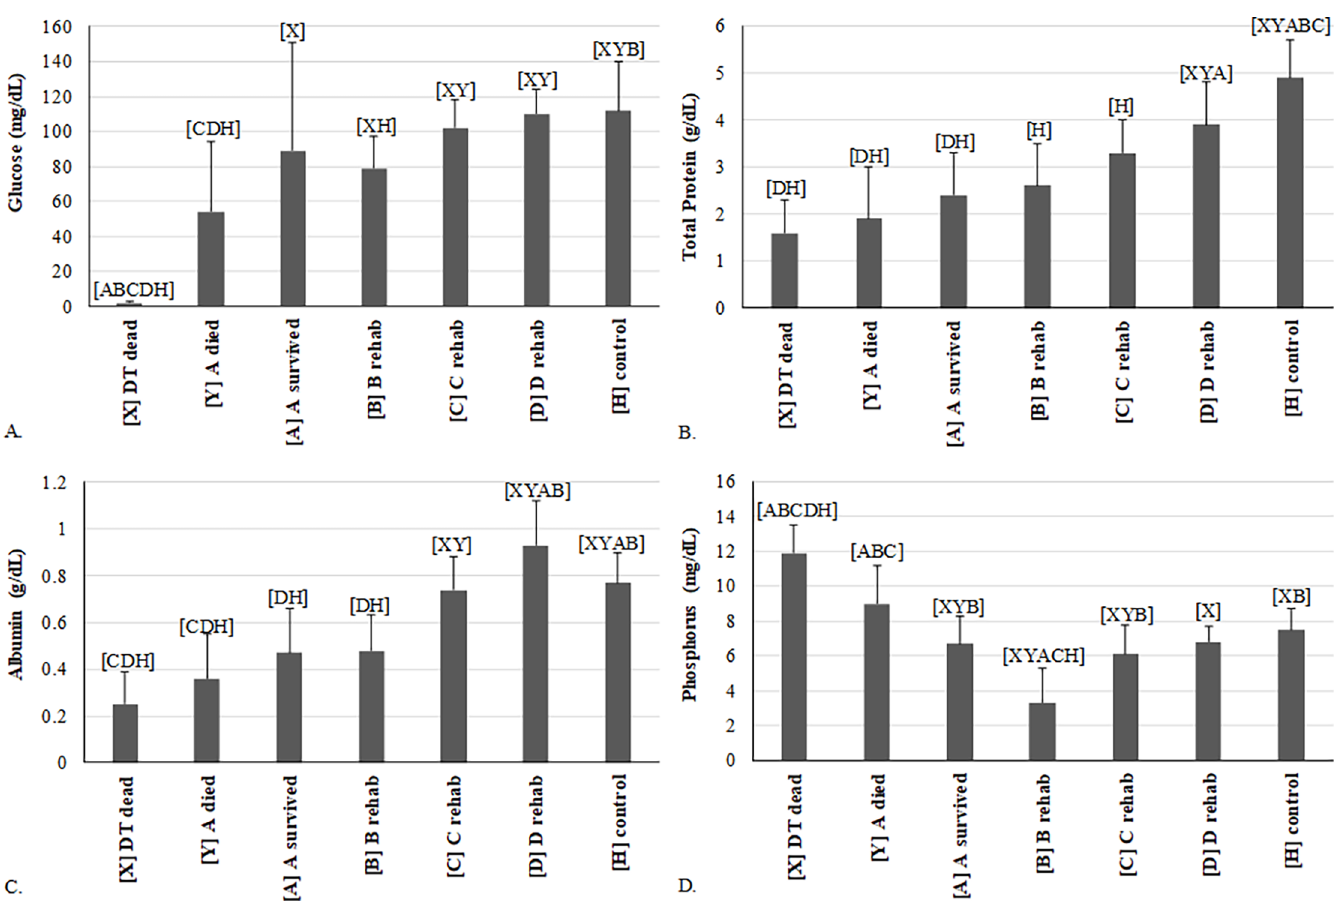
Fig 4. Comparison of variables measured in debilitated loggerhead sea turtles (DTs) before and during rehabilitation and compared to healthy loggerhead turtles (means and one standard deviation). Each turtle group on the x-axis was significantly different (p < 0.05 or p < 0.00883 for repeated measures) from groups represented by letters above data. (A) glucose; (B) total protein by biuret method at U. Miami; (C) albumin by plasma electrophoresis; (D) phosphorus. Lines represent an individual turtle through rehabilitation. For samples sizes in each diagram, please refer to S3